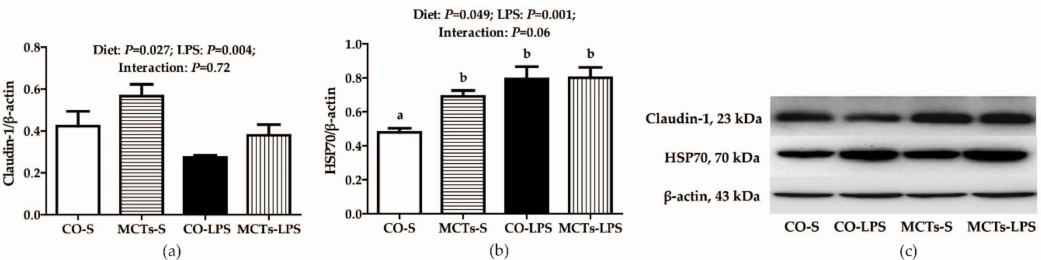
Figure 3. Effect of medium-chain triglyceride (MCT) supplementation on claudin-1 ( a ) and heat shock protein 70 (HSP70) ( b ) protein expression in the liver after 4-h LPS challenge in pigs. The bands are the representative Western blot images ( c ). Values are mean and SE, n = 6 (1 pig/pen). Means with